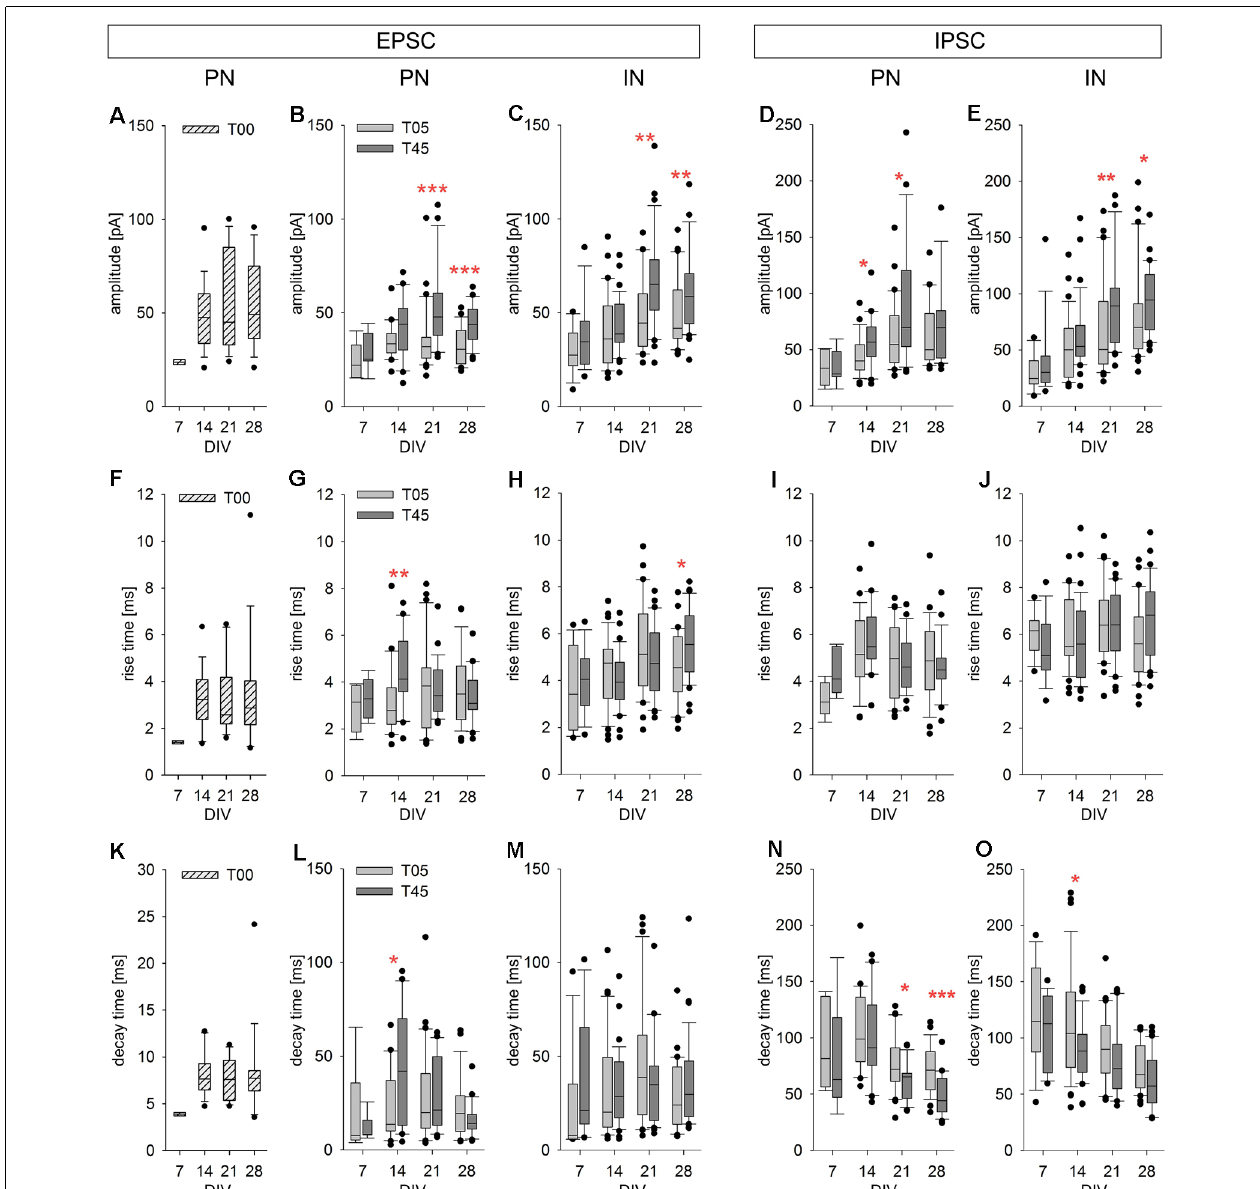
FIGURE 9 | Developmental changes of isolated spontaneous PSCs in PNs and INs. The spontaneous postsynaptic currents analyzed for this and the next figure (see also Table 2 ) were isolated events during the interburst interval (see examples in Figure 8D , arrows). The box plots show the developmental changes of PSC amplitude (A–E) , rise time (F–J) , and decay time (K–O) for EPSCs [PNs (T00: A,F,K ; T05 and T45: B,G,L ); INs ( C,H,M )] and IPSCs [PNs ( D,I,N ); INs ( E,J,O )]. T00: hatched boxes; T05: light gray boxes; T45: dark gray boxes. Asterisks indicate significant differences between network types (* P ≤ 0.05, ** P ≤ 0.01, *** P ≤ 0.001). For the number of cells and statistically significant age differences, see Table 2